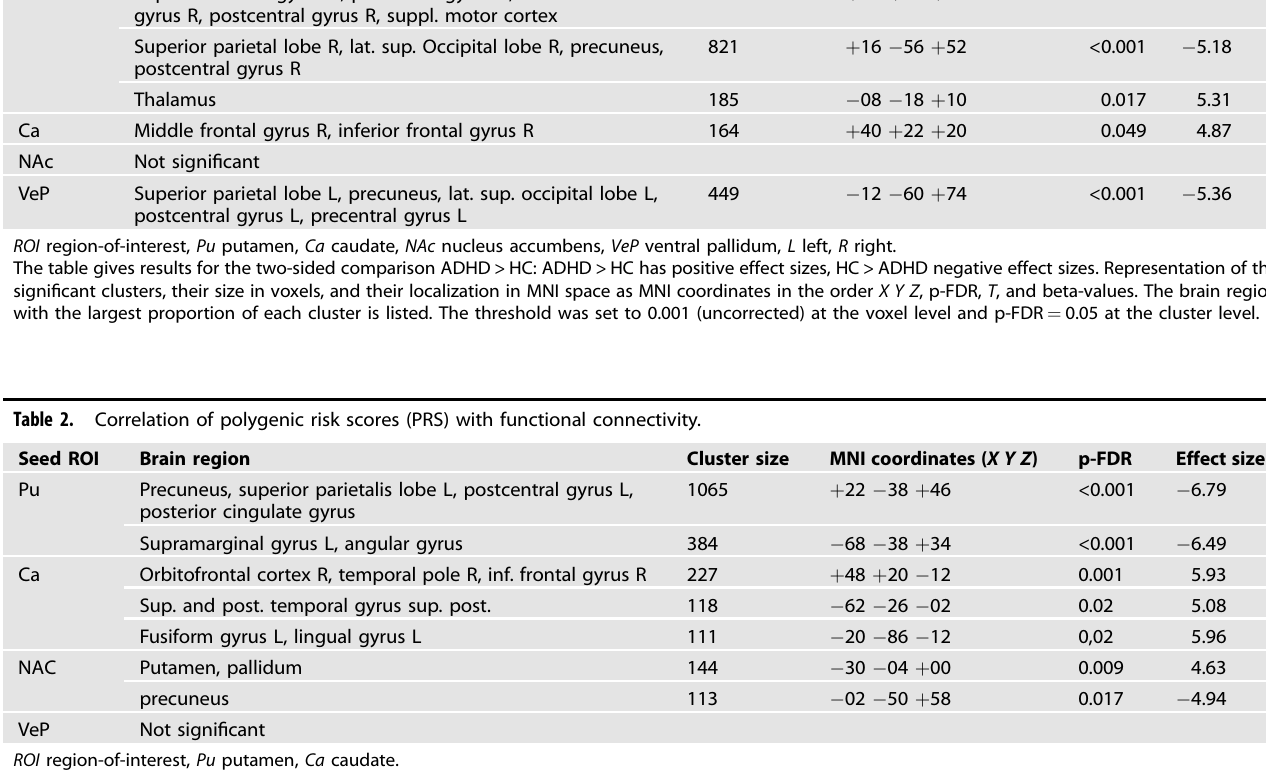
ROI region-of-interest, Pu putamen, Ca caudate. The table gives results for the correlation of polygenic risk scores (PRS) during the placebo condition. Representation of the signi fi cant clusters, their size in voxels, and their localization in MNI space as MNI coordinates in the order X Y Z , p-FDR, T , and beta-values. The brain region with the largest proportion of each cluster is listed. The threshold was set to 0.001 (uncorrected) at the voxel level and p-FDR = 0.05 at the cluster